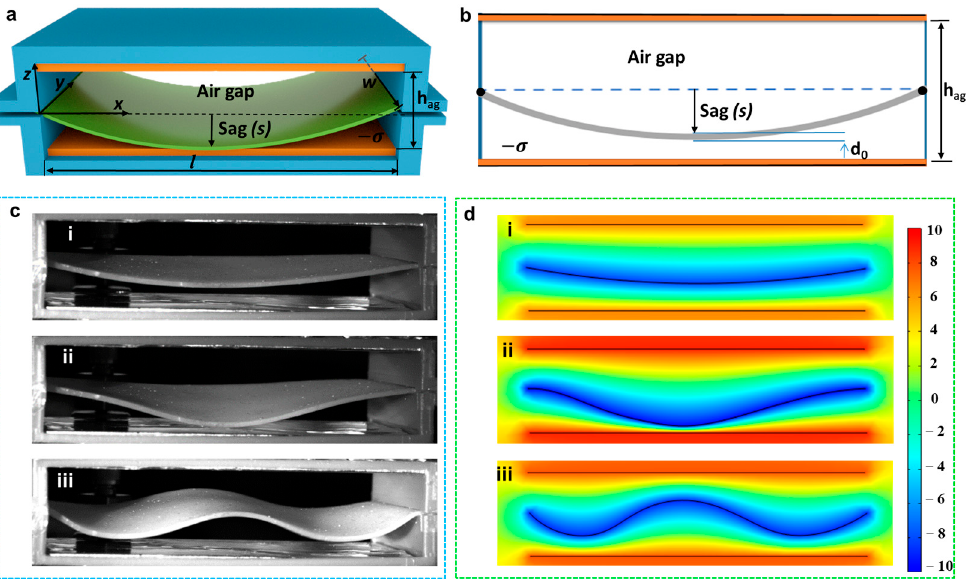
Figure 2. Analysis of the movement of silicone rubber strip. ( a ) The coordinate system of the SRS- TENG shown in the 3D structure; ( b ) parameters of the SRS-TENG; ( c ) silicone rubber strip taken by high-speed camera and ( d ) its corresponding simulation result by COMSOL Multiphysics at vibration frequencies of ( i ) 10 Hz, ( ii ) 30 Hz and ( iii ) 50 Hz, respectively.